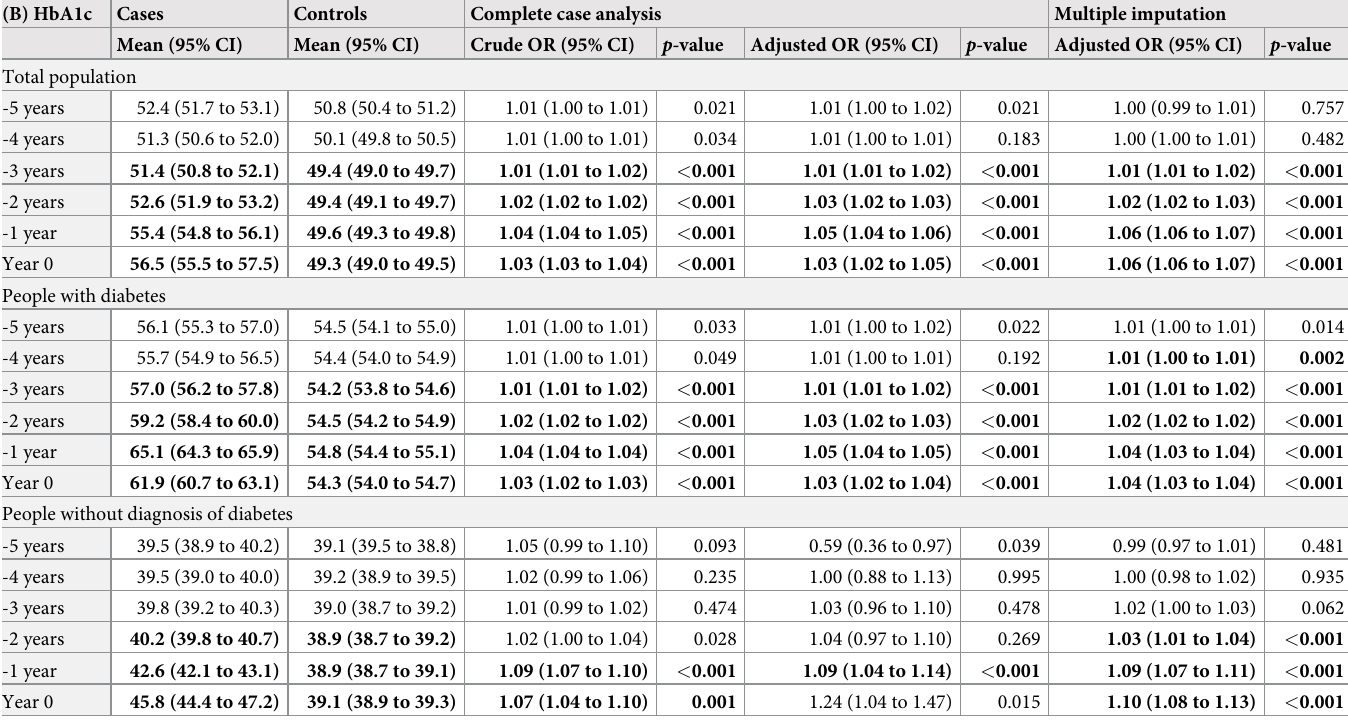
Table 3. Odds ratios (OR) and 95% confidence intervals (CI) for the association of pancreatic cancer with increase in glycated haemoglobin (HbA1c), i.e., hypergly- caemia over time with calculated conditional logistic regression. Subgroup analysis by diabetes. Bolded text indicates statistically significant results. Statistical signifi- cance was considered at p <